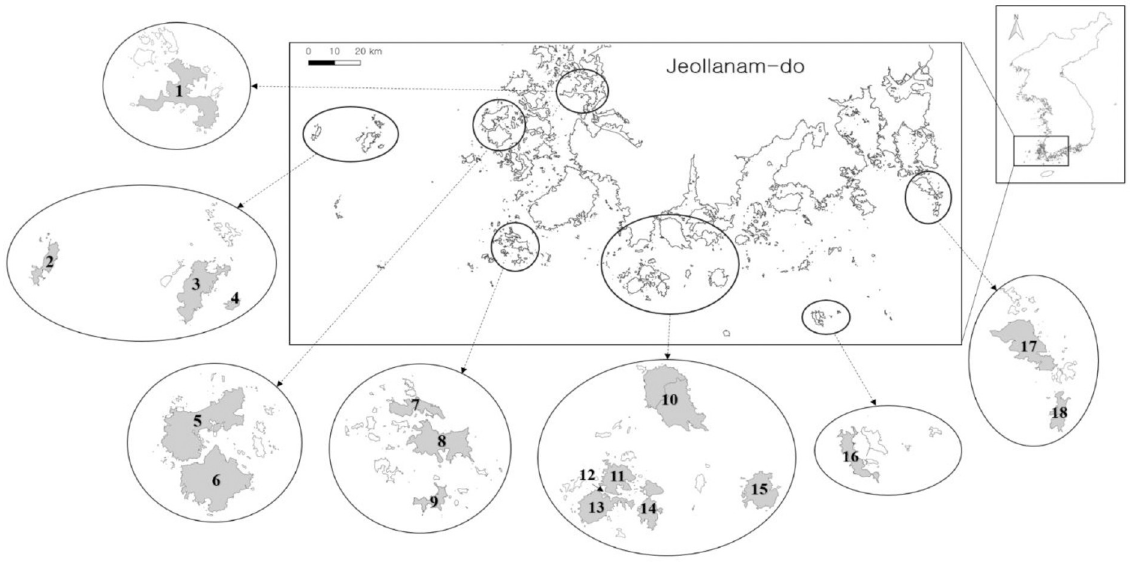
Fig 1. Map showing the surveyed 18 islands in southwest Korea : 1. Aphaedo, 2. Hongdo, 3. Heuksando, 4. Yongsando, 5. Bigeumdo, 6. Dochodo, 7. Sangjodo, 8. Hajodo, 9. Gwanmaedo, 10. Wando, 11. Nohwado, 12. Jangsado, 13. Bogildo, 14. Soando, 15. Cheongsando, 16. Geomundo (Seodo), 17. Geumodo, 18. Yeondo.